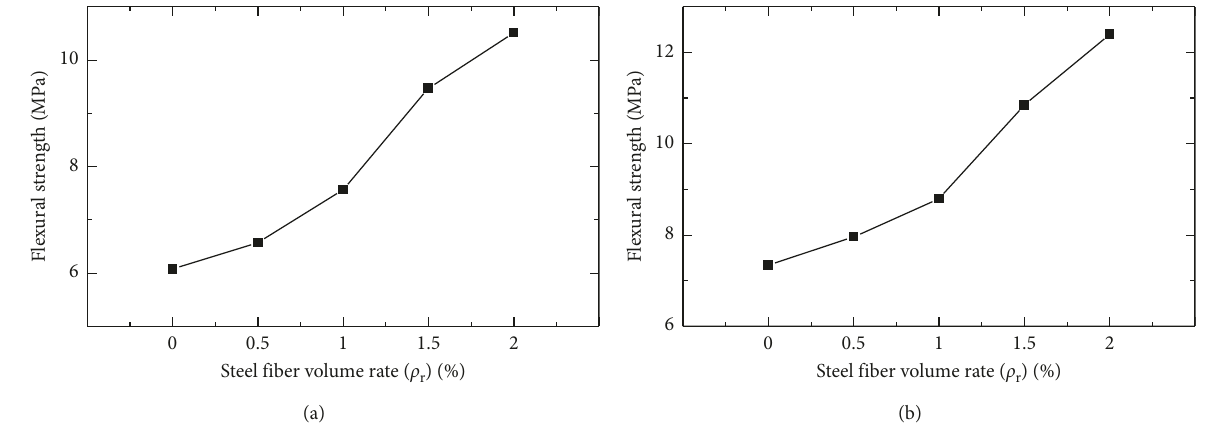
Figure 15: Relationship between flexural strength and steel fiber content. (a) CF50; (b)